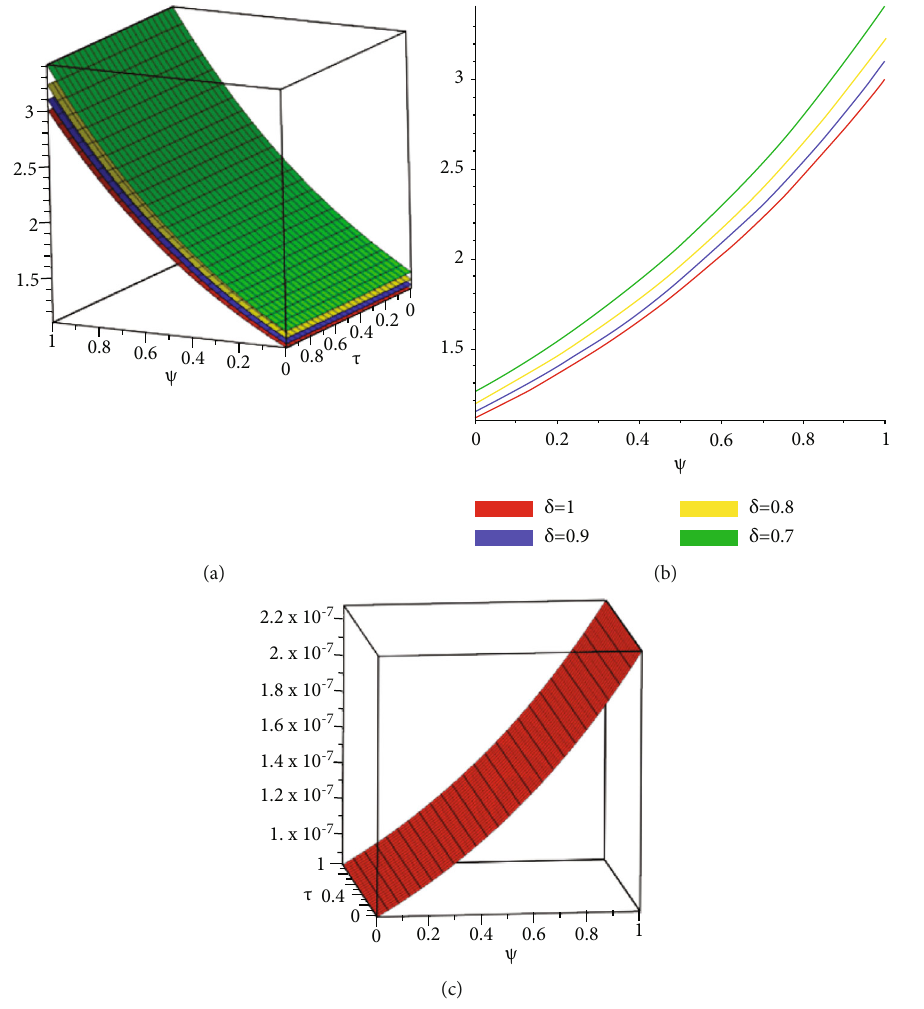
Figure 2: Example 1. (a) Analytical solution at various fractional orders of σ (b) ϕ = 0 : 5 and (c) Table 1: ν ð ψ , τ Þ comparison of exact solution, our methods ’ solution, and Absolute Error (AE) of Example 1.